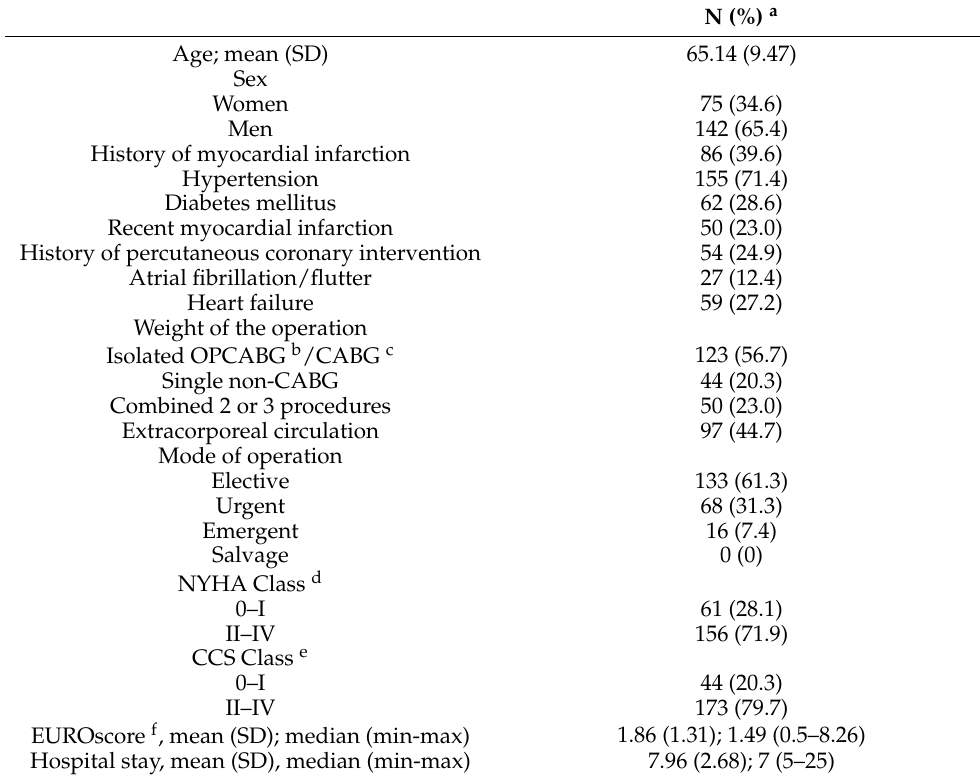
Table 1. Clinical and socio-demographic data of the studied population ( n =